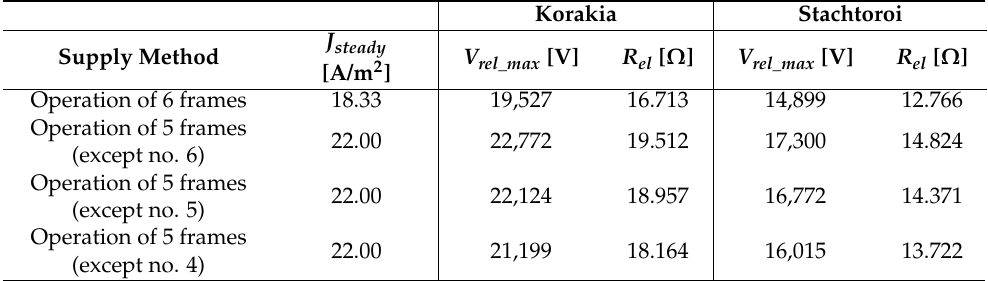
Table 15. Results of determination of absolute electric potential and resistance between electrode station and remote earth by applying method “A” for the far field ( ρ S = ∞ ) and method “C” for the near field, with simplifying admissions ( ρ S = ∞ ) and compensation for the presence of a dam; for an electrode station of 6 linear frames in a row, d frames = 6.50 m (area of Korakia) and 4.50 m (area of Stachtoroi), each frame consisted of 13 electrodes of active length L = 2.13 m, D el = 0.50 m, ρ d = 100 Ω · m, ρ w = 0.25 Ω · m, θ w = 2.29 ◦ , θ = 248 ◦ (area of Korakia) and θ w = 0.272 ◦ , θ = 210 ◦ (area of